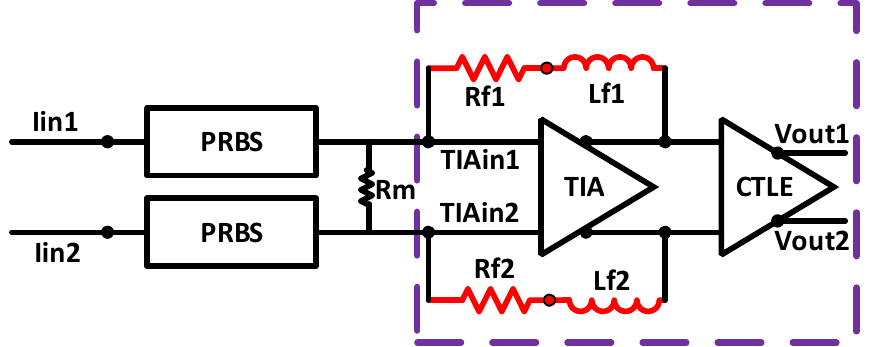
Figure 9. Receiver AFE Architecture.